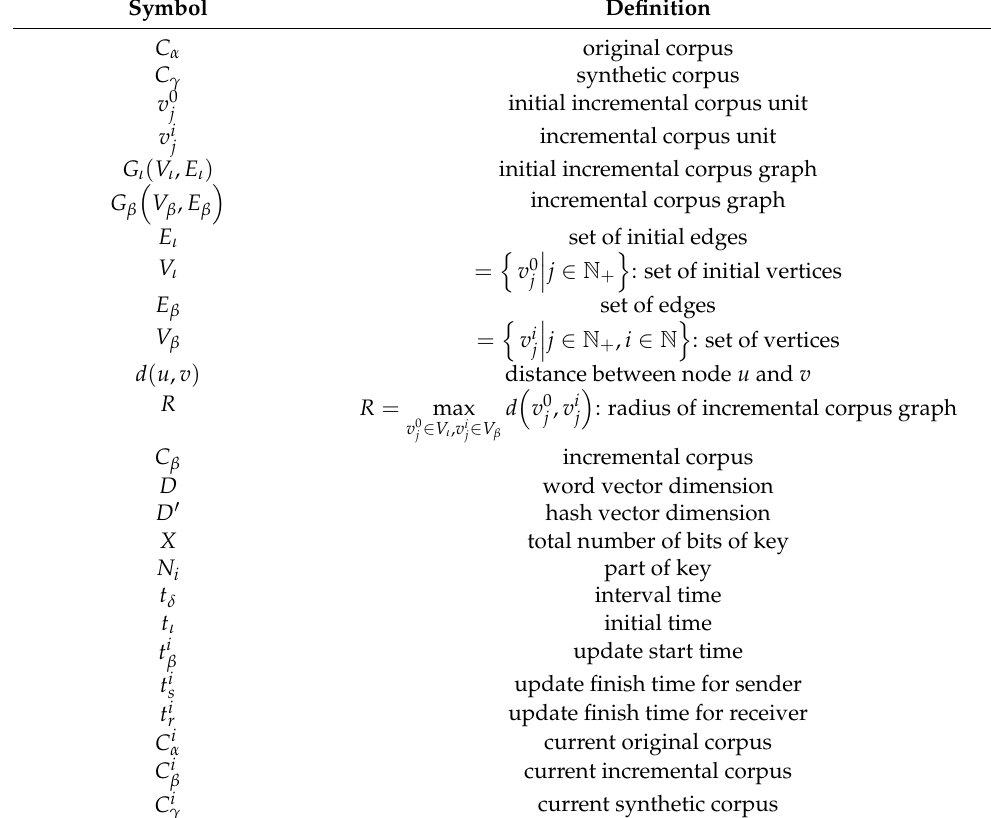
Table 1. Symbols and